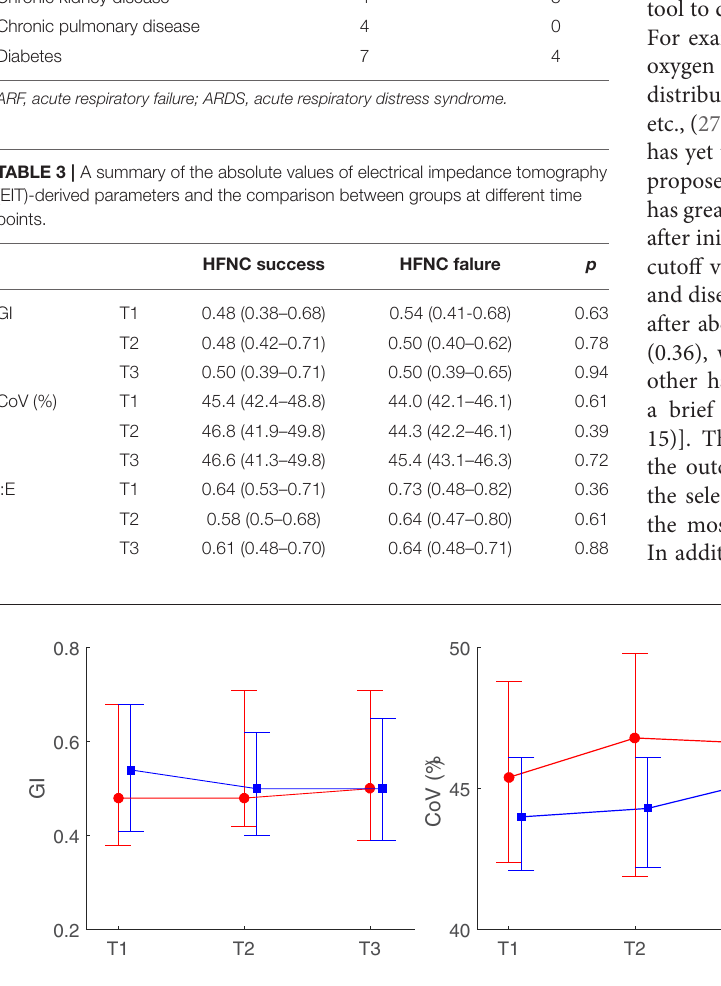
FIGURE 1 | Illustration of electrical impedance tomography (EIT)-derived parameters at different time points between high flow nasal cannula (HFNC) success and failure groups. GI, the global inhomogeneity index; CoV, center of ventilation; I:E, inspiration to the expiration time. T1, before HFNC; T2, 30min after HFNC started; T3, 1h after HFNC